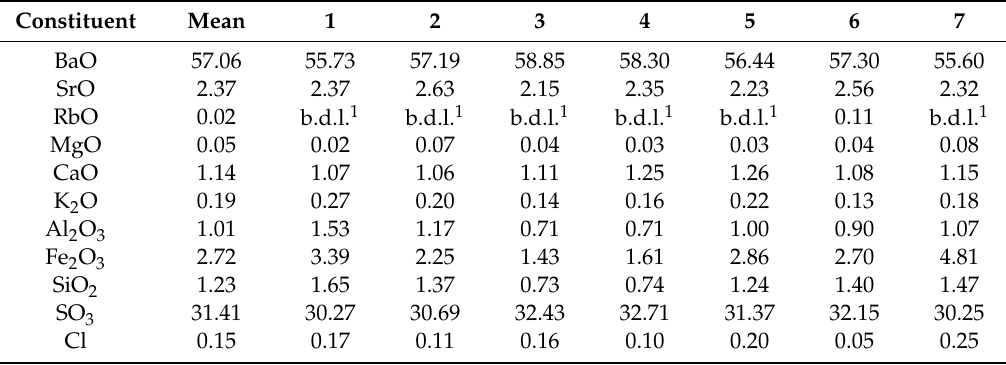
Table 2. Chemical composition of studied precipitate and empirical formula of baryte based on 4 oxygens per formula